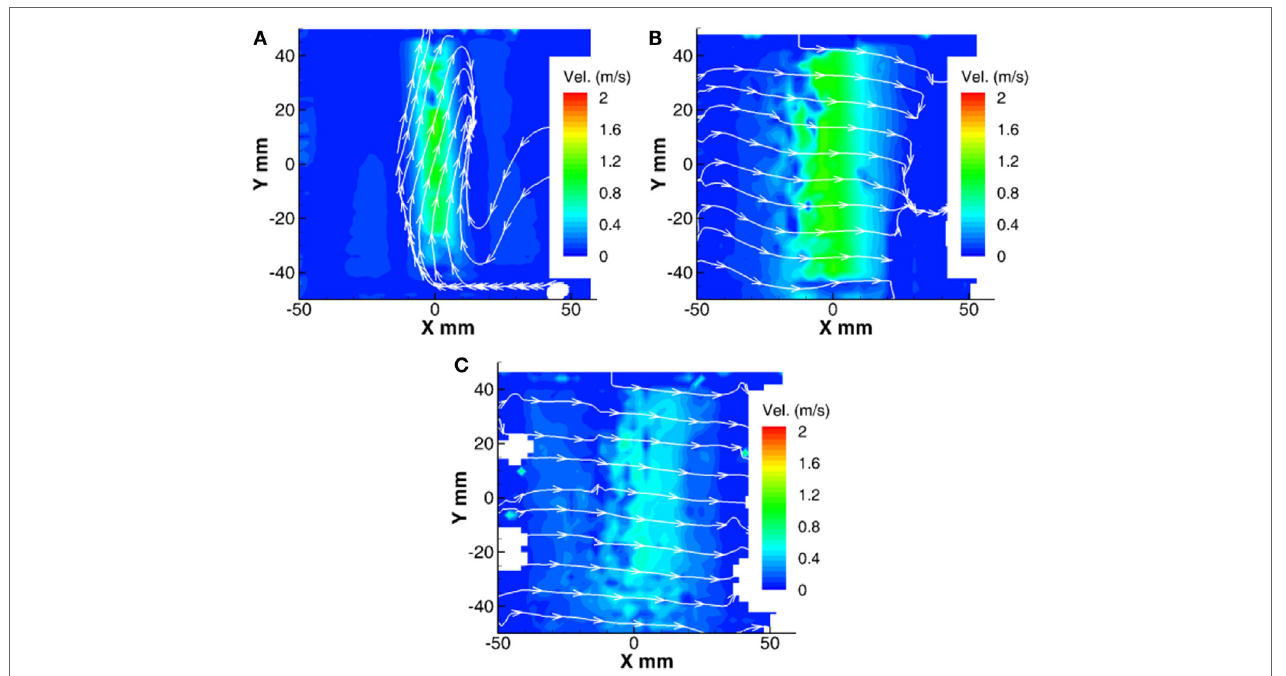
FigUre 4 | Velocity contours at deviated traverse position (a) 0 mm, (B) 12.7 mm, and (c) 25.4 mm at 300 K and 1 atm